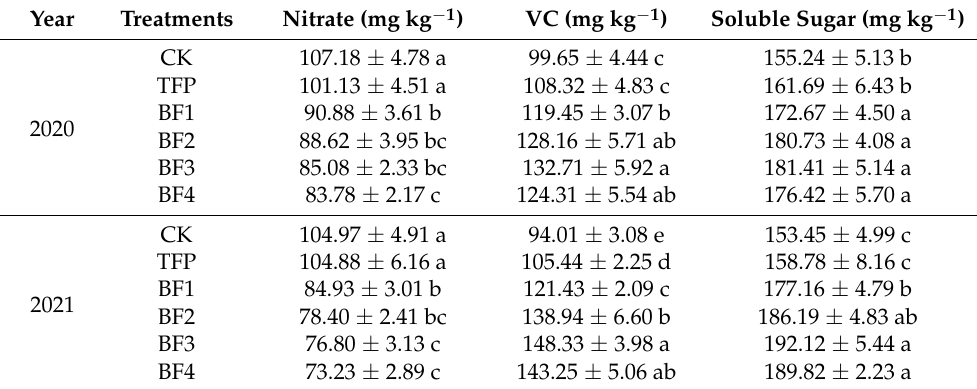
Table 2. Effects of BF on quality of fresh eggplant in 2020 and 2021.